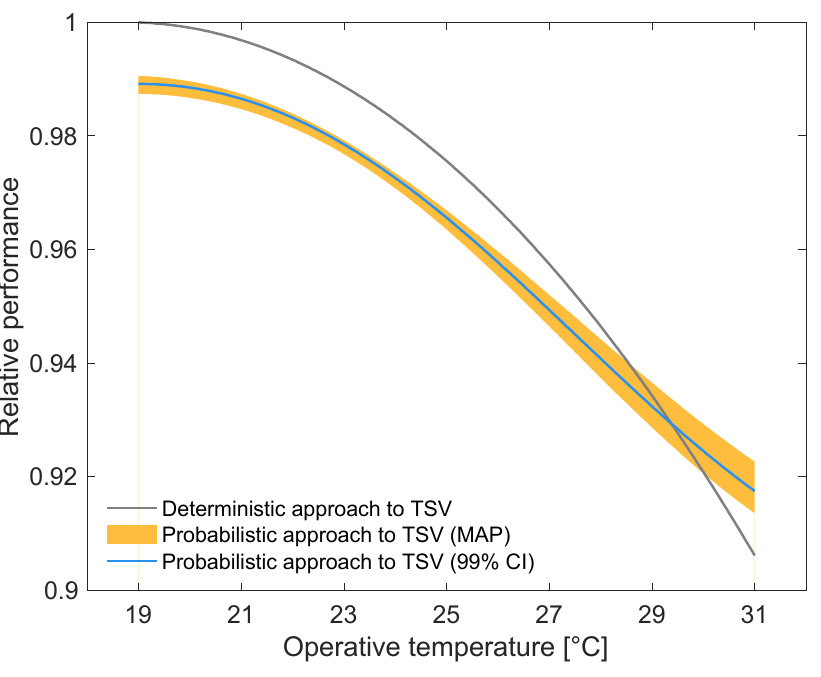
Figure 6. Relationship between the operative temperature and the relative performance of occupants carrying out regular office